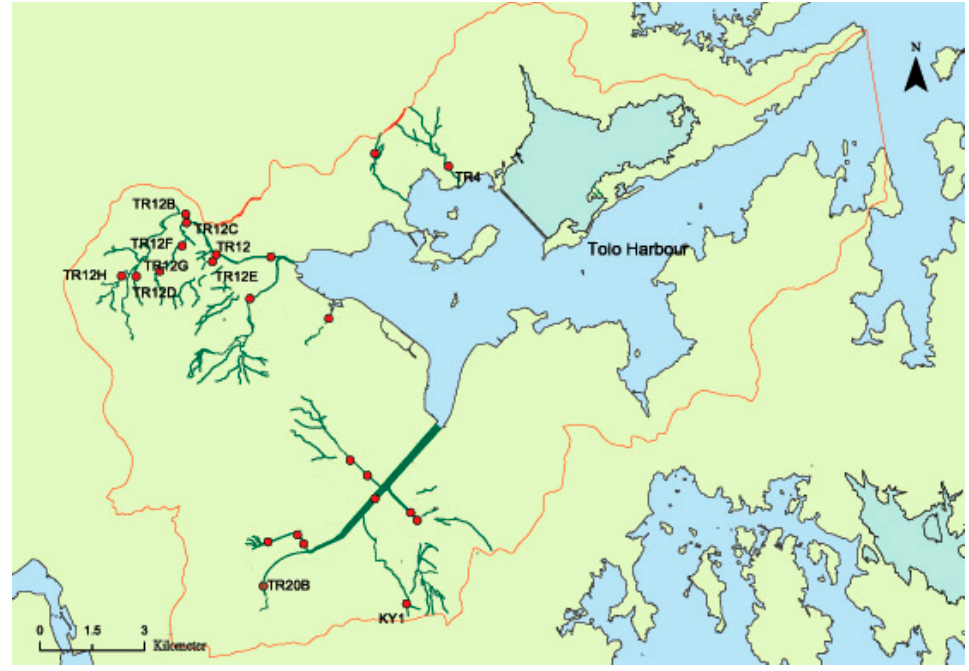
Figure 1. Locations of the 11 monitoring stations in the zone.